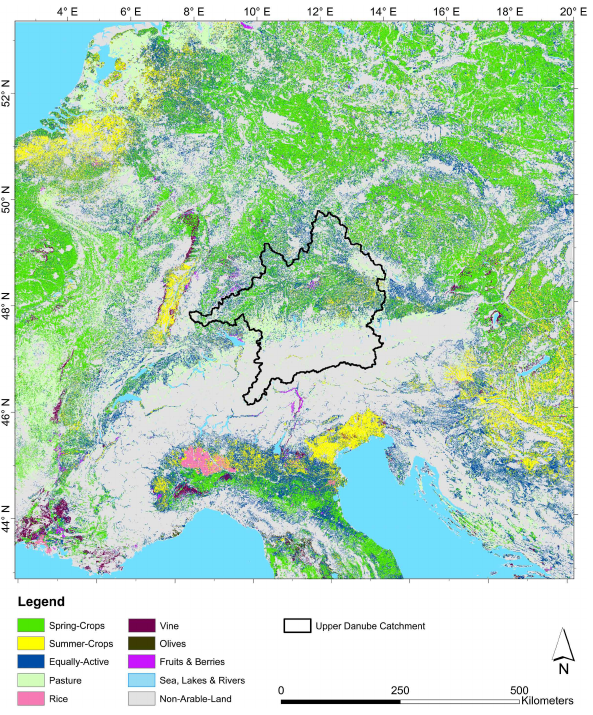
Fig. 6. Phenological subclasses of arable land from CLC after split- ting with MERIS NDVI.